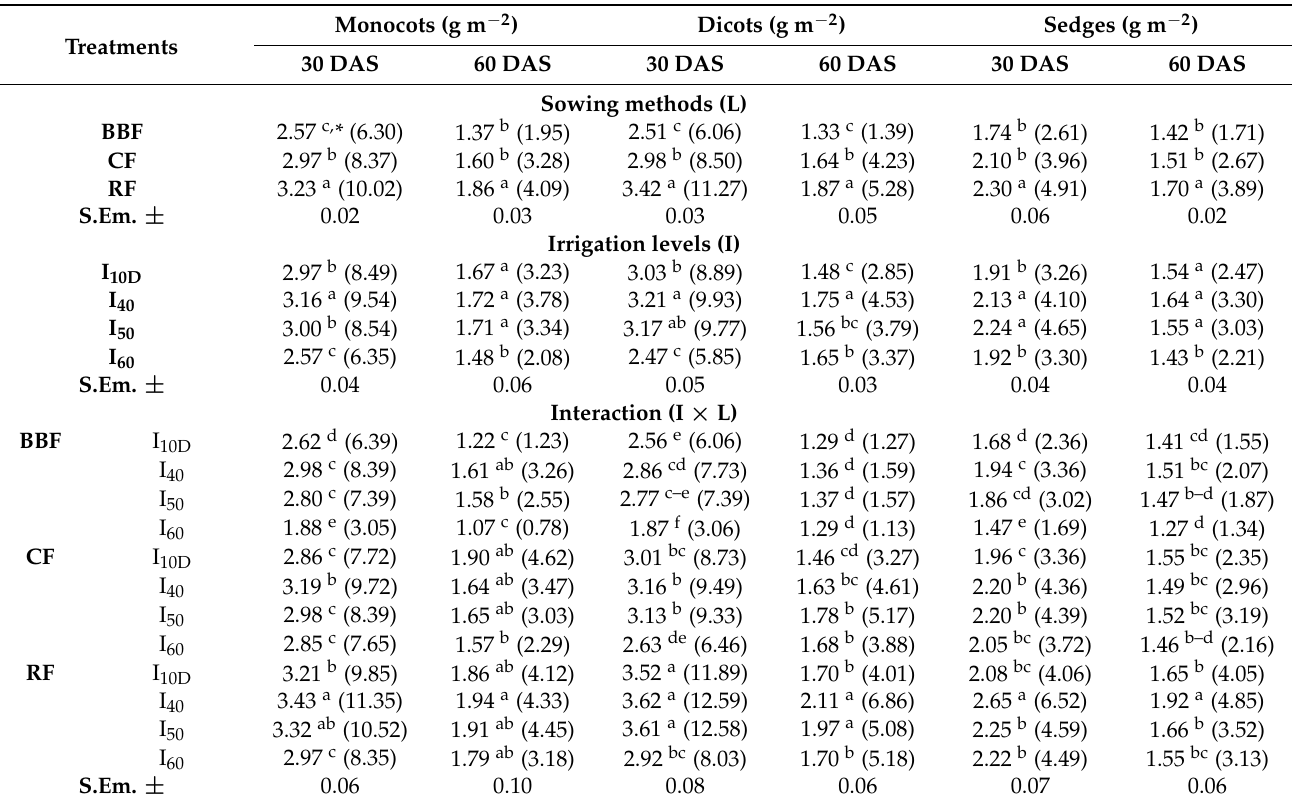
Table 4. Dry weight of monocot, dicot and sedge weeds as influenced by sowing methods and irrigation levels in maize (pooled data of 2015 and